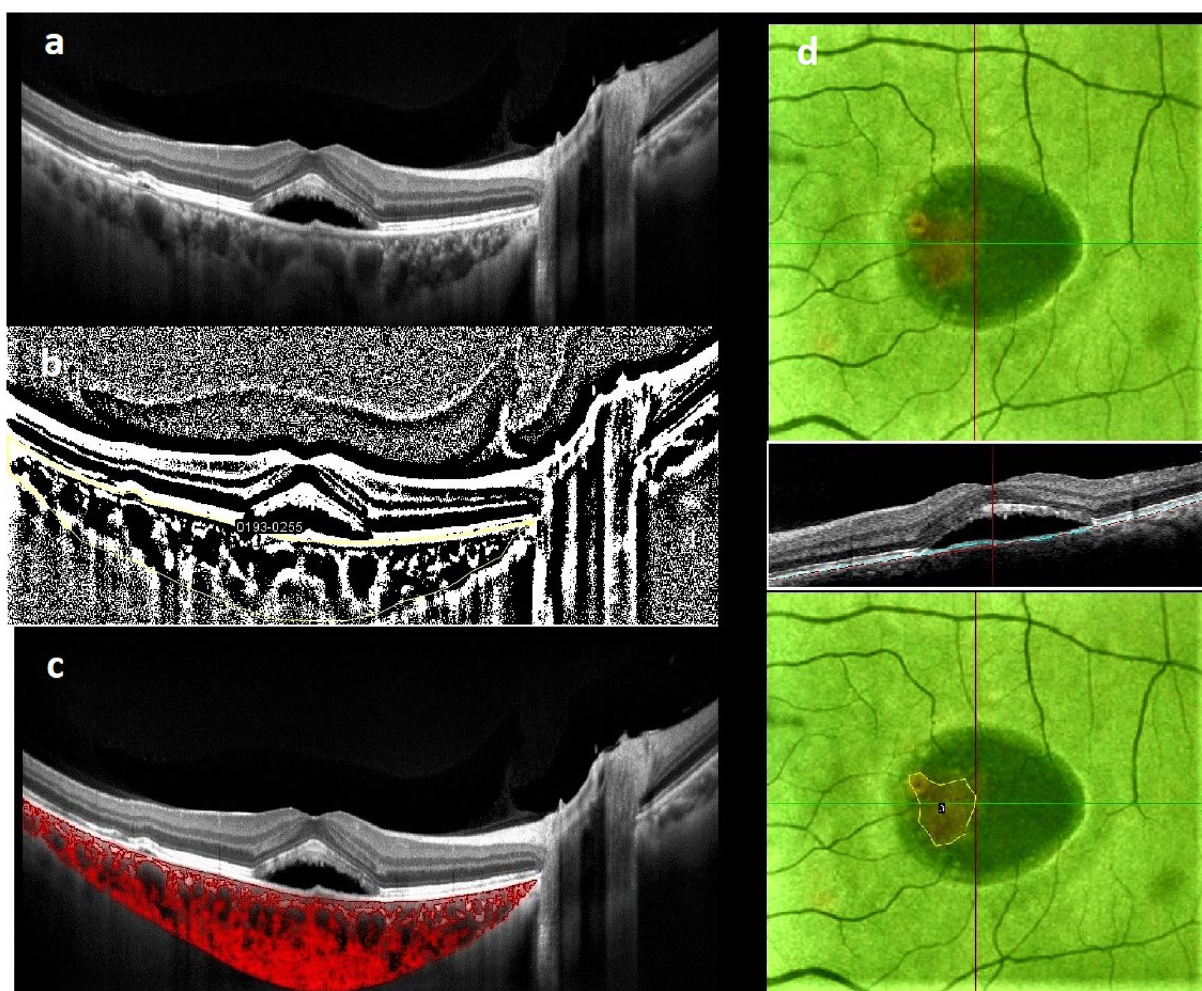
Figure 1. Measurement of choroidal parameters: subfoveal choroidal thickness is measured manually from the base of RPE to the innermost border of choroidoscleral junction ( a ). Choroidal area is delineated followed by binarization of the region of interest ( b ). The image is then converted to RGB using color threshold, and the choroidal vascular index is calculated by dividing areas without pixels as choroidal lumens to total choroidal area ( c ). PED area is evident in en-face RPE map as hot regions, which is manually delineated ( d average brightness was set as the minimum value to reduce the noise in the OCT image. The ROI was selected and set by the ROI manager in the OCT image. Then, the image was converted to 8 bits and adjusted by the auto local threshold of Niblack. The binarized image was reconverted to an RGB image, and the luminal area was determined using the color threshold tool. The light pixels were described as the choroidal stroma or interstitial area and the dark pixels were defined as the luminal area (LA). TCA, LA, and stromal area (SA) was automati- cally calculated. Herein, we refer to the ratio of LA to TCA as the choroidal vascular index (CVI) (Fig. 1b, c). Measurement of PED area. En face RPE elevation map were used to depict the total PED area (Fig. 1d). Images were imported to FIJI and scales were set accordingly. Borders of PED, which were demonstrated as hot colors in heat map image provided by the built-in software of the device, were manually selected using the free hand tool of FIJI. PED area at baseline and follow-up images were measured and used for analysis. Statistical methods. To describe data, we used mean, standard deviation, median, range, frequency, and percentage. To compare the results between groups when considering the probable correlation of the eyes, we used generalized estimating equation (GEE). Multiple comparisons are considered by the Sidak method. Asso- ciation of baseline predictive factors to the alteration of BCVA were assessed using linear model within GEE method. To compare intergroup baseline characteristics we performed ANOVA test, and post hoc pairwise com- parison was adjusted with Sidak method. Comparison of intergroup follow-up characteristics was performed using ANCOVA, which adjusts possible confounding effect of baseline values. A P value of less than 0.05 is con- sidered statistically significant. All statistical analysis was performed by SPSS (IBM Corp. Released 2017. IBM